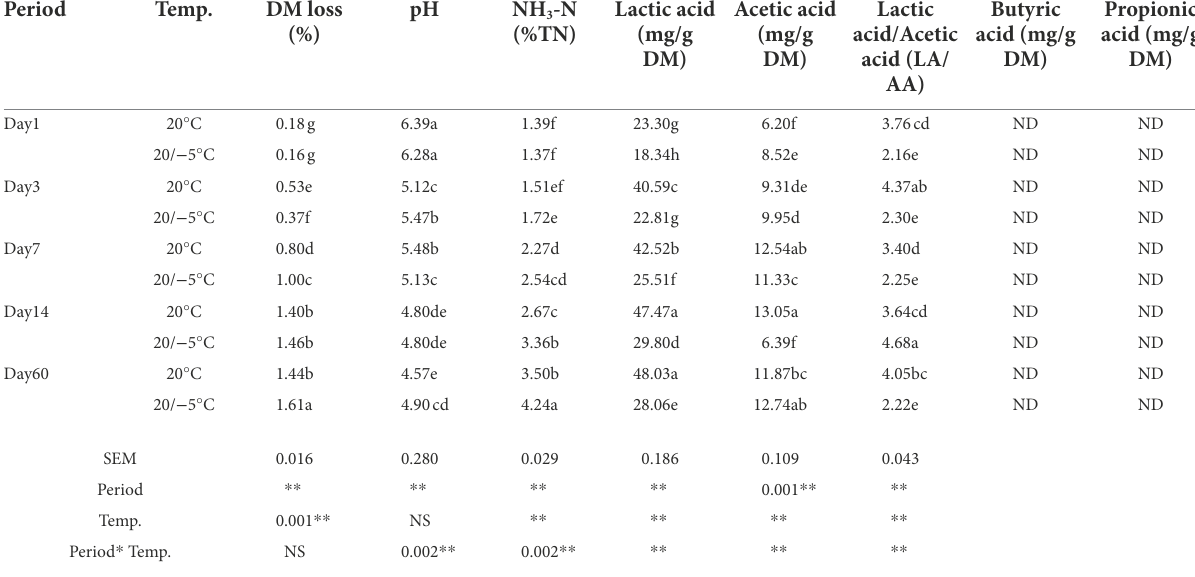
TABLE 1 Fermentation characteristics and dry matter (DM) loss of oat silage ensiled for 60 days. Period Temp.